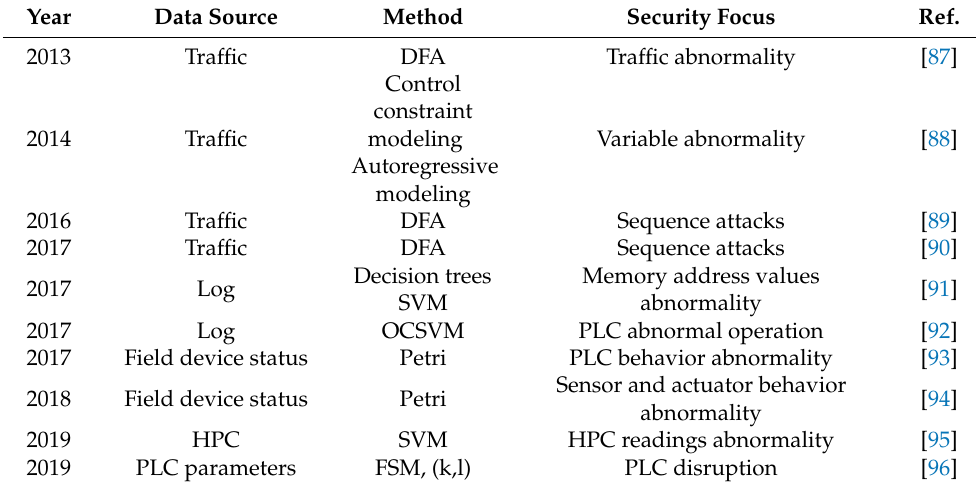
Table 3. Main findings in the intrusion